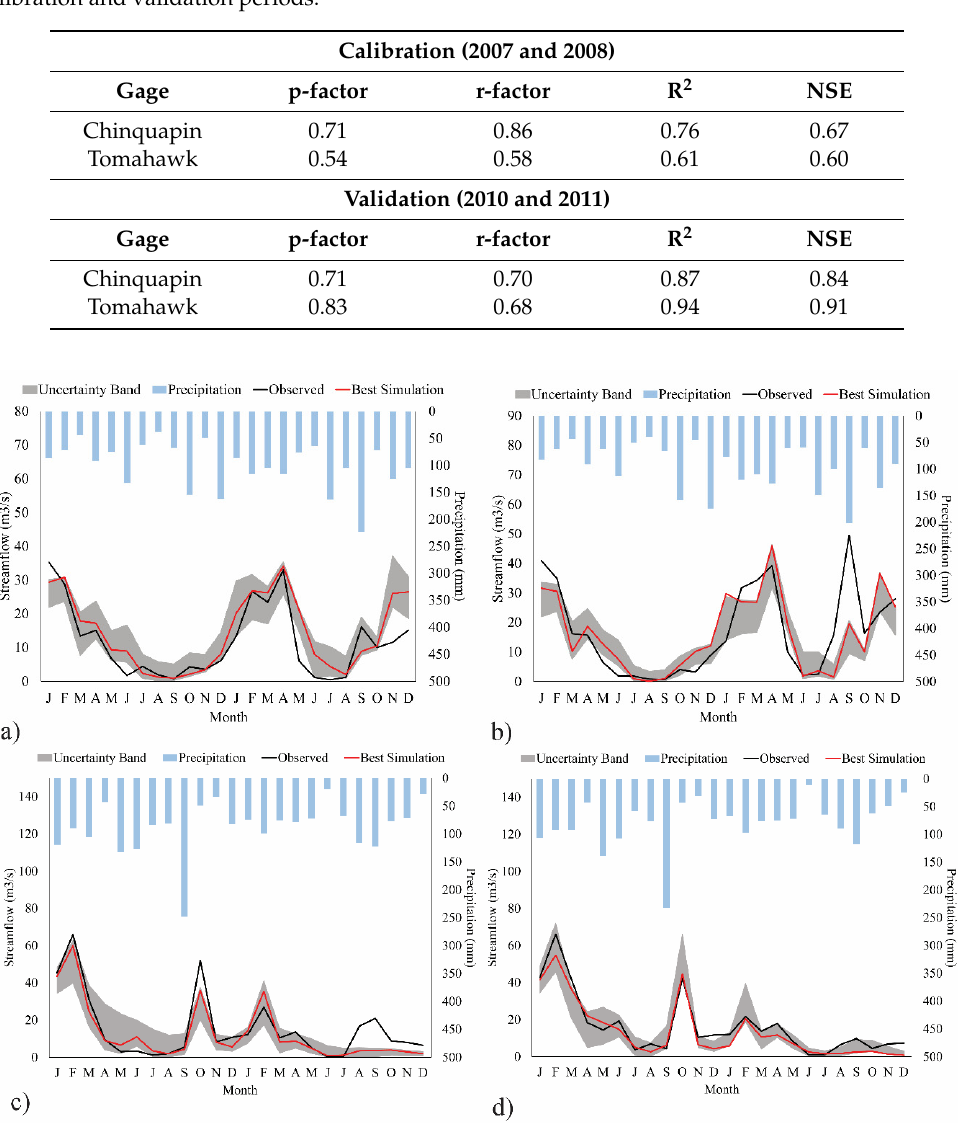
Figure 2. Monthly streamflow calibration and validation using SUFI-2, Northeast Cape Fear basin. The calibration period (January 2007–December 2008) is shown for Chinquapin station ( a ) and Tomahawk station ( b ). The validation period (January 2010 to December 2011) is shown for Chinquapin station ( c ) and Tomahawk station ( d ). The uncertainty band is depicted by a light gray band, which represents the 95PPU or p-factor of streamflow calibration. See Table 6 for model performance statistics.